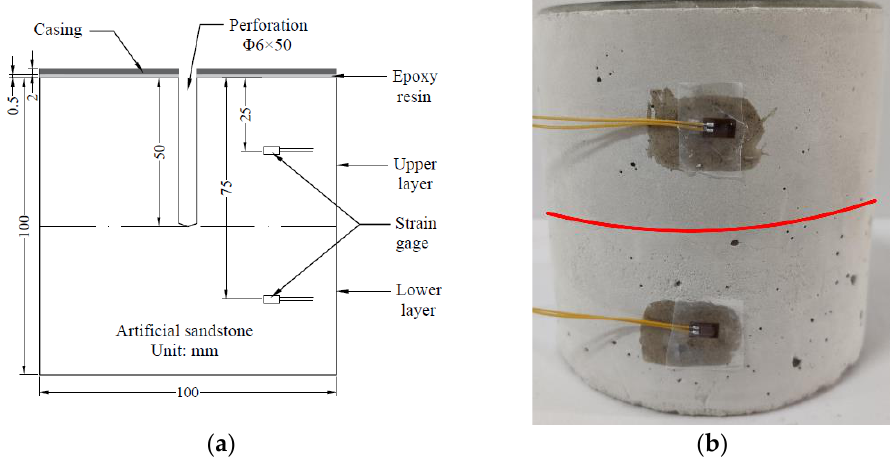
Figure 2. The preparation of specimens. ( a ) A schematic diagram of the cylindrical specimen; ( b ) the completed specimen.